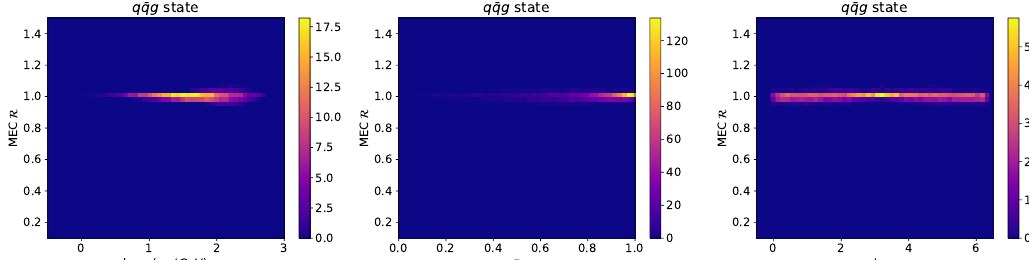
Figure 3: Consistency validation of parton shower and matrix element description of q ¯ qg state, plotted against the shower transverse momentum, the energy fraction of the gluon and the azimuthal angle of the gluon emission. The color indicates the normalized sampling rate of the respective points. In this case, all phase space points are well approximated by the parton shower, such that the MEC factor close to one.